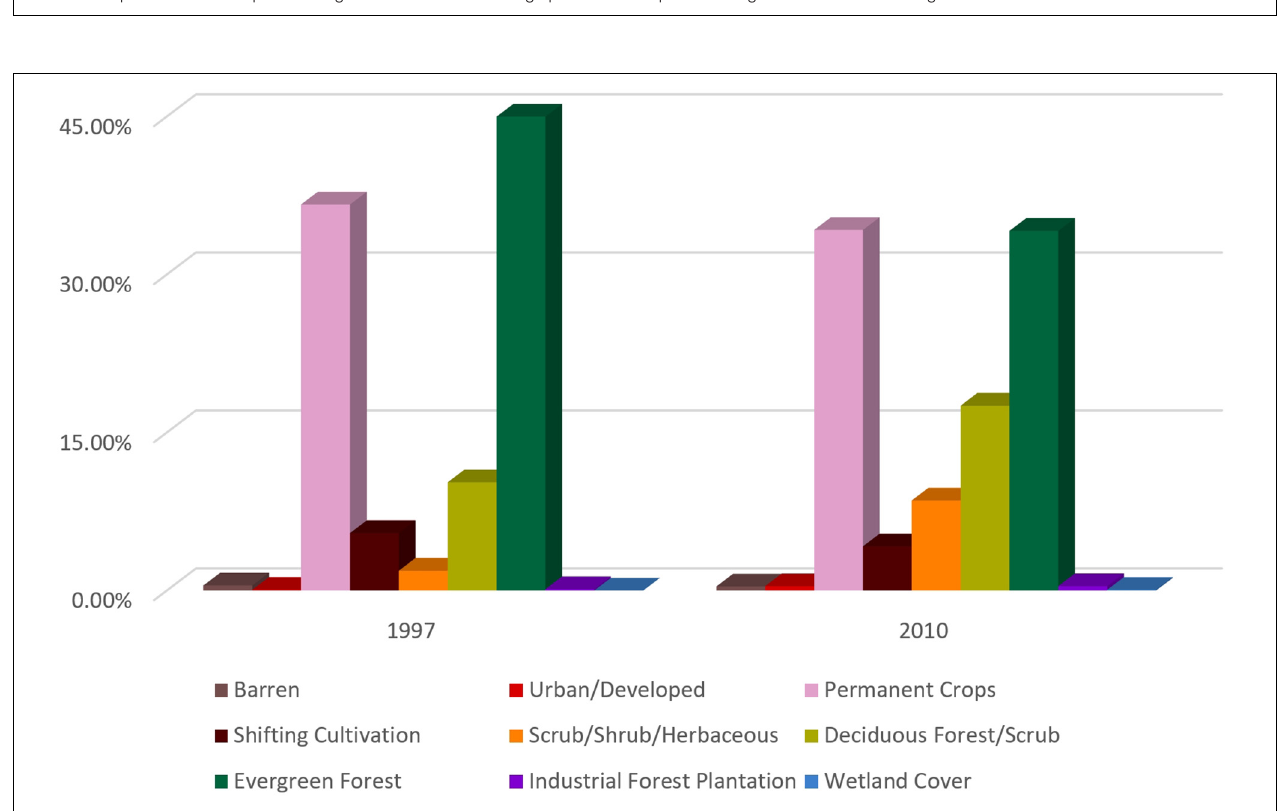
FIGURE 5 | Results of LULC change map accuracy assessment, including percent overall agreement of LULC change map, 1997 LULC map, and 2010 LULC map was well as percent user and producer agreement for the no change permanent crops and evergreen forest LULC change classes.